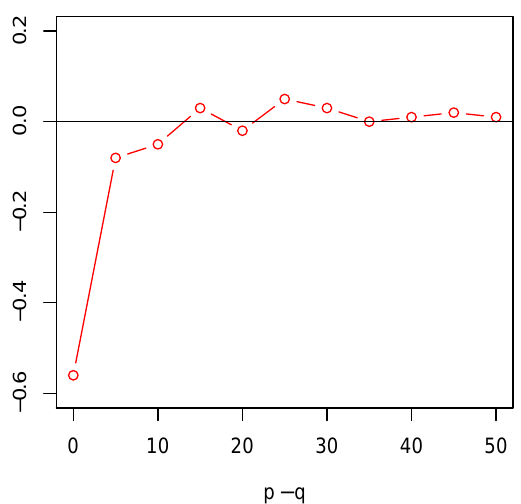
Figure 4. Difference in proportions of selecting true model: P c ( λ 1 se ) − P c ( λ min ) (positive means 1se is better).